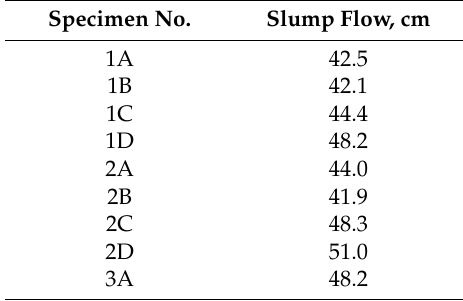
Table 3. Slump flow of